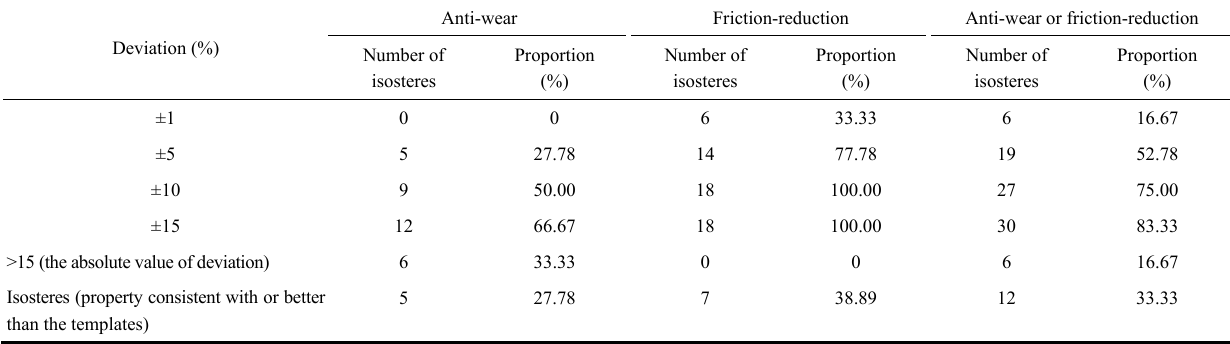
Fig. 31 The structural formula of the compound.